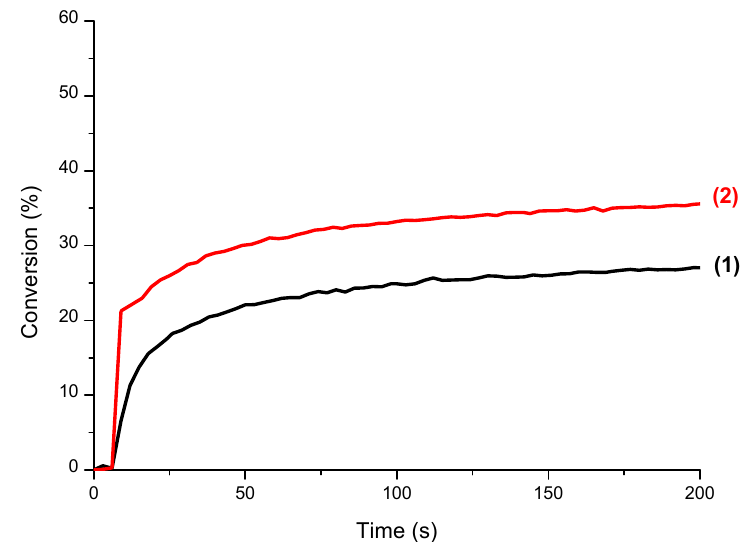
Figure 7. Photopolymerization profiles (methacrylate function conversion vs. irradiation time) for a BisGMA / TEGDMA (70 / 30 % w / w ) resin blend (under air; 20 µ m thin films) upon exposure to the LED@477 nm (I 0 = 300 mW · cm − 2 ) using di ff erent photoinitiating systems. (1) CQ / EDB (1 / 1 % w / w ); (2) CQ / EDB / S5 (1 / 1 / 1 % w / w ). The irradiation starts for t = 5s.